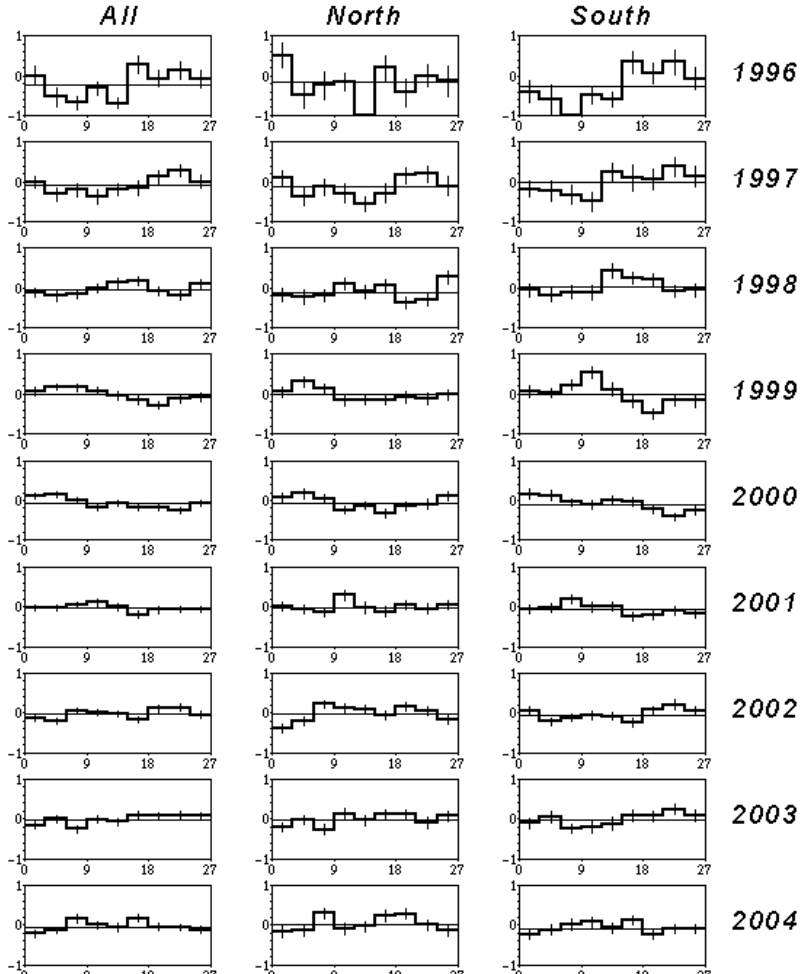
Fig. 1. Superposed epoch distribution of the east-west asymmetry, for 9 years of SOHO LASCO observations. The asymmetry is calculated in 3-day bins, corresponding to 40 ◦ longitudinal zones. The left panels concern all the data, the middle and right panels are for the Northern and Southern Hemispheres, respectively. Full halo CMEs are excluded. Data for 1998 and 1999 are incomplete due to the SOHO data gaps in 1998 June–October and 1999 January. The horizontal thin lines mark asymmetry calculated for the whole year. The error bars represent 1 σ statistical